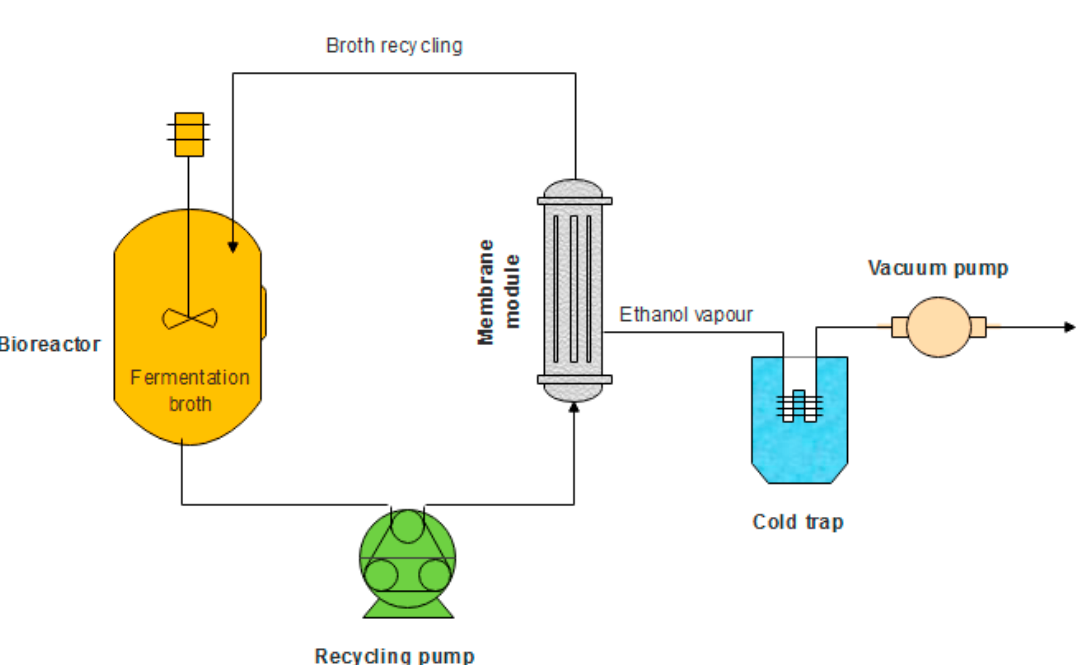
Figure 2. Diagram for fermentation process coupled with pervaporation separation unit.